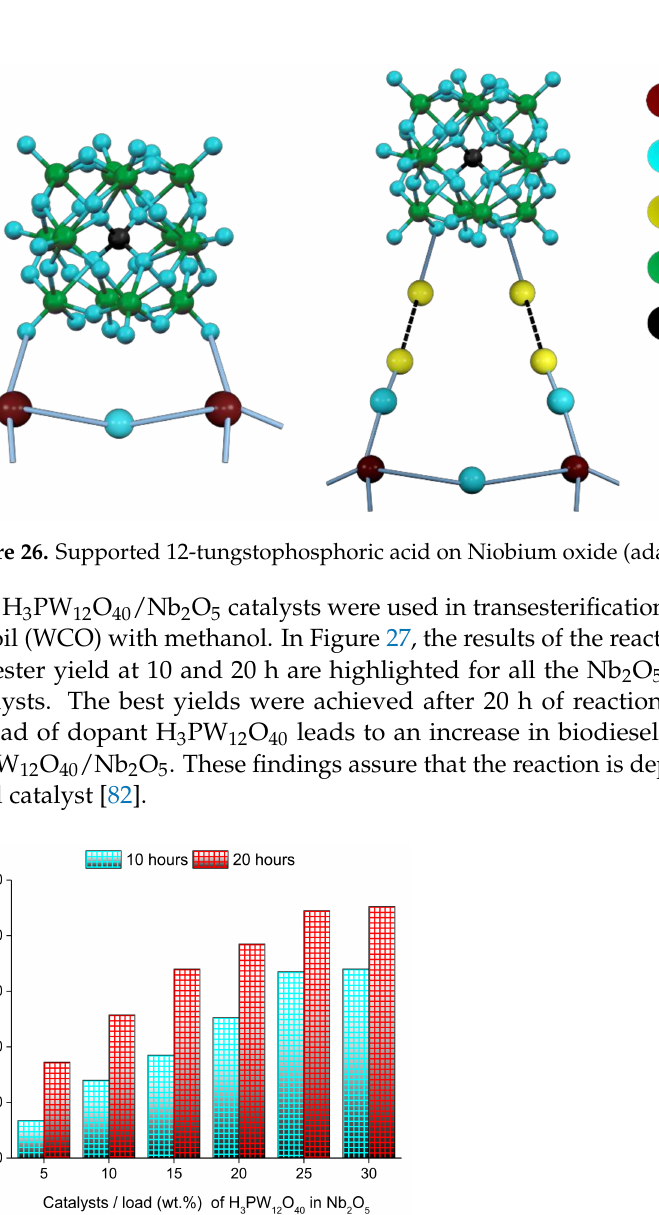
Figure 27. Ester yield on used cooking oil transesterification reaction by the H 3 PW 12 O 40 /Nb 2 O 5 catalysts. Reaction conditions: wasting cooking oil (0.115 mol), methyl alcohol (2.069), temperature (200 ◦ C) (adapted from